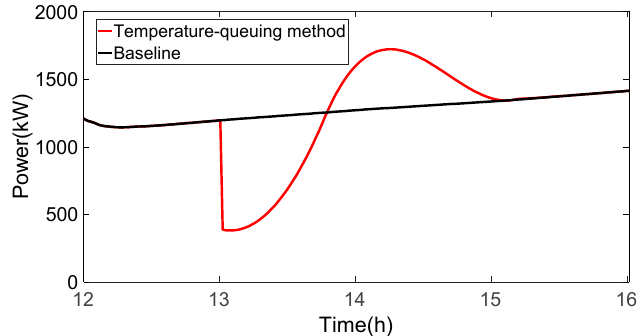
Figure 14. Total power of aggregated IAC load.